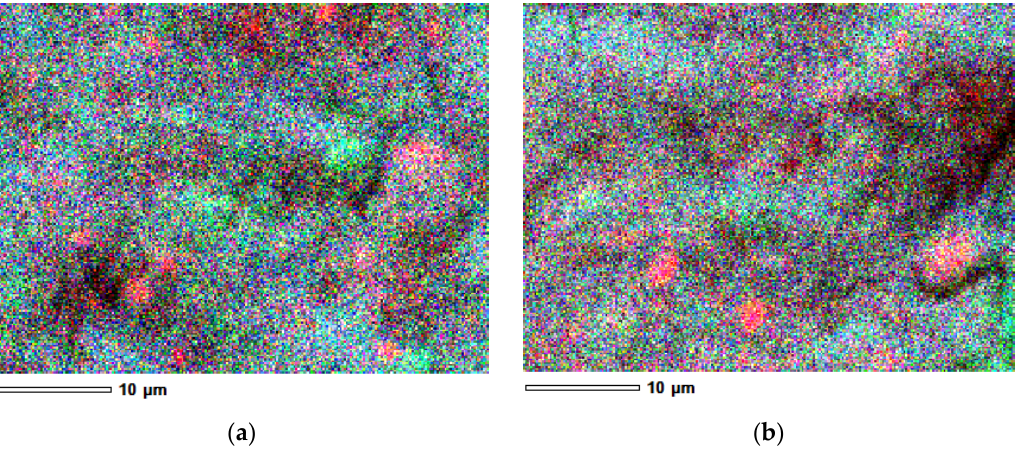
Figure 6. Scatter diagram of elements in geopolymer samples. ( a ) MZr05 and ( b ) MZr15.